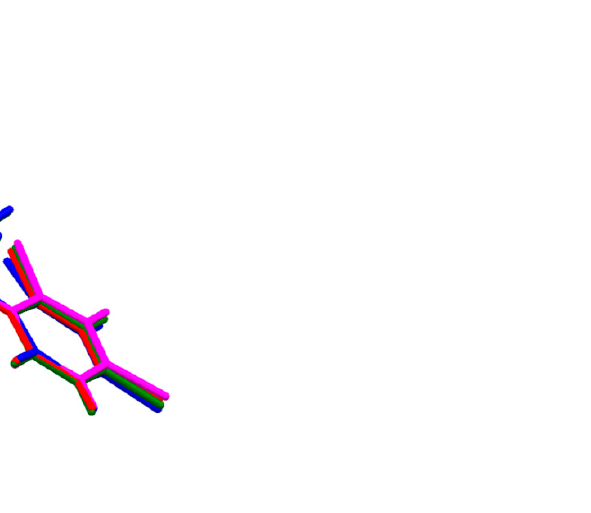
Figure 3. A superposition of miconazole ligands in Ag(I) complexes with different counter ions: nitrate (blue) ( 1 ), perchlorate (green) ( 2 ), tetrafluoroborate (red) ( 3 ), hexafluoroantimonate (magenta) ( 4 ). The best fit for C1, C2 and N1 atoms.